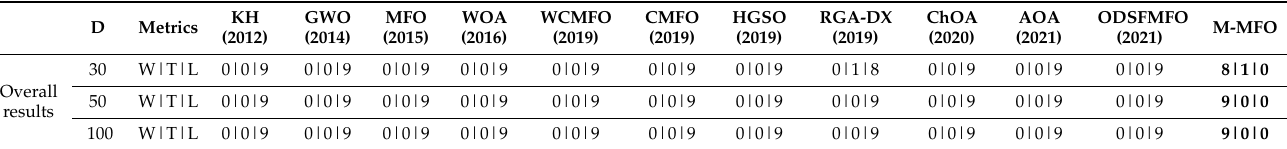
Table 3. The overall results of the M-MFO and comparative algorithms on unimodal and multimodal test functions. D